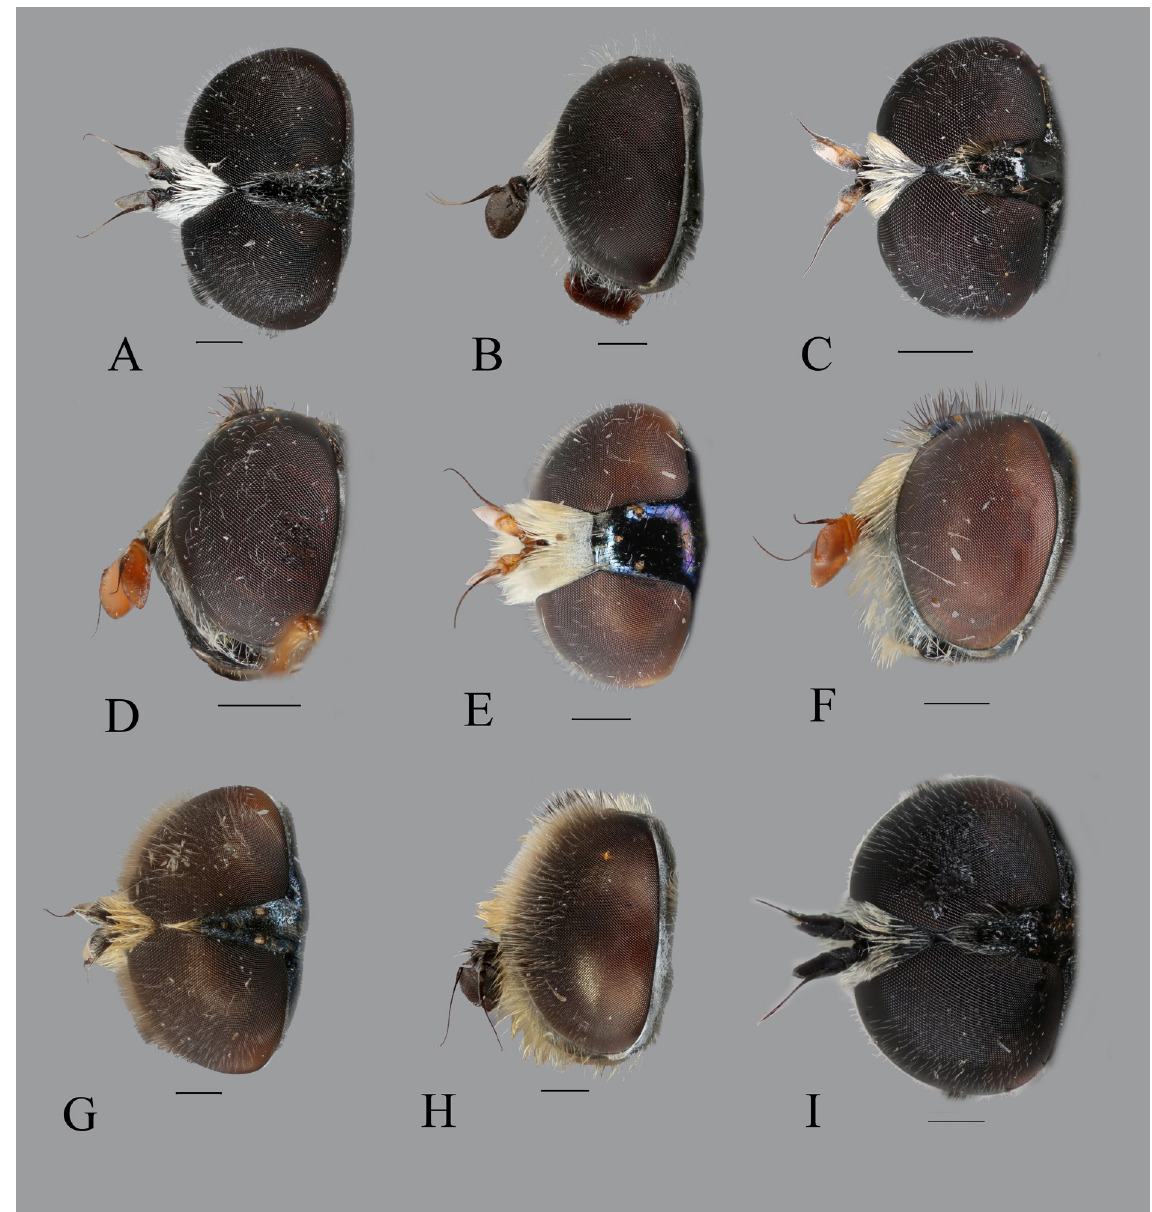
Fig. 13. Head, ♂, dorsal view (A, C, E, G, I) and lateral view (B, D, F, H). A–B . Eumerus atricolorus Gilasian & van Steenis sp. nov., holotype (HMIM). C–D . E. brevipilosus Gilasian & van Steenis sp. nov., holotype (HMIM). E–F . E. falsus Becker, 1922, Chekab Valley, Iran (HMIM). G–H . E. chekabicus Gilasian & van Steenis sp. nov., holotype (HMIM). I . E. tricolor (Fabricius, 1798), Paleochori, Greece (JSA). Scale bars = 0.5